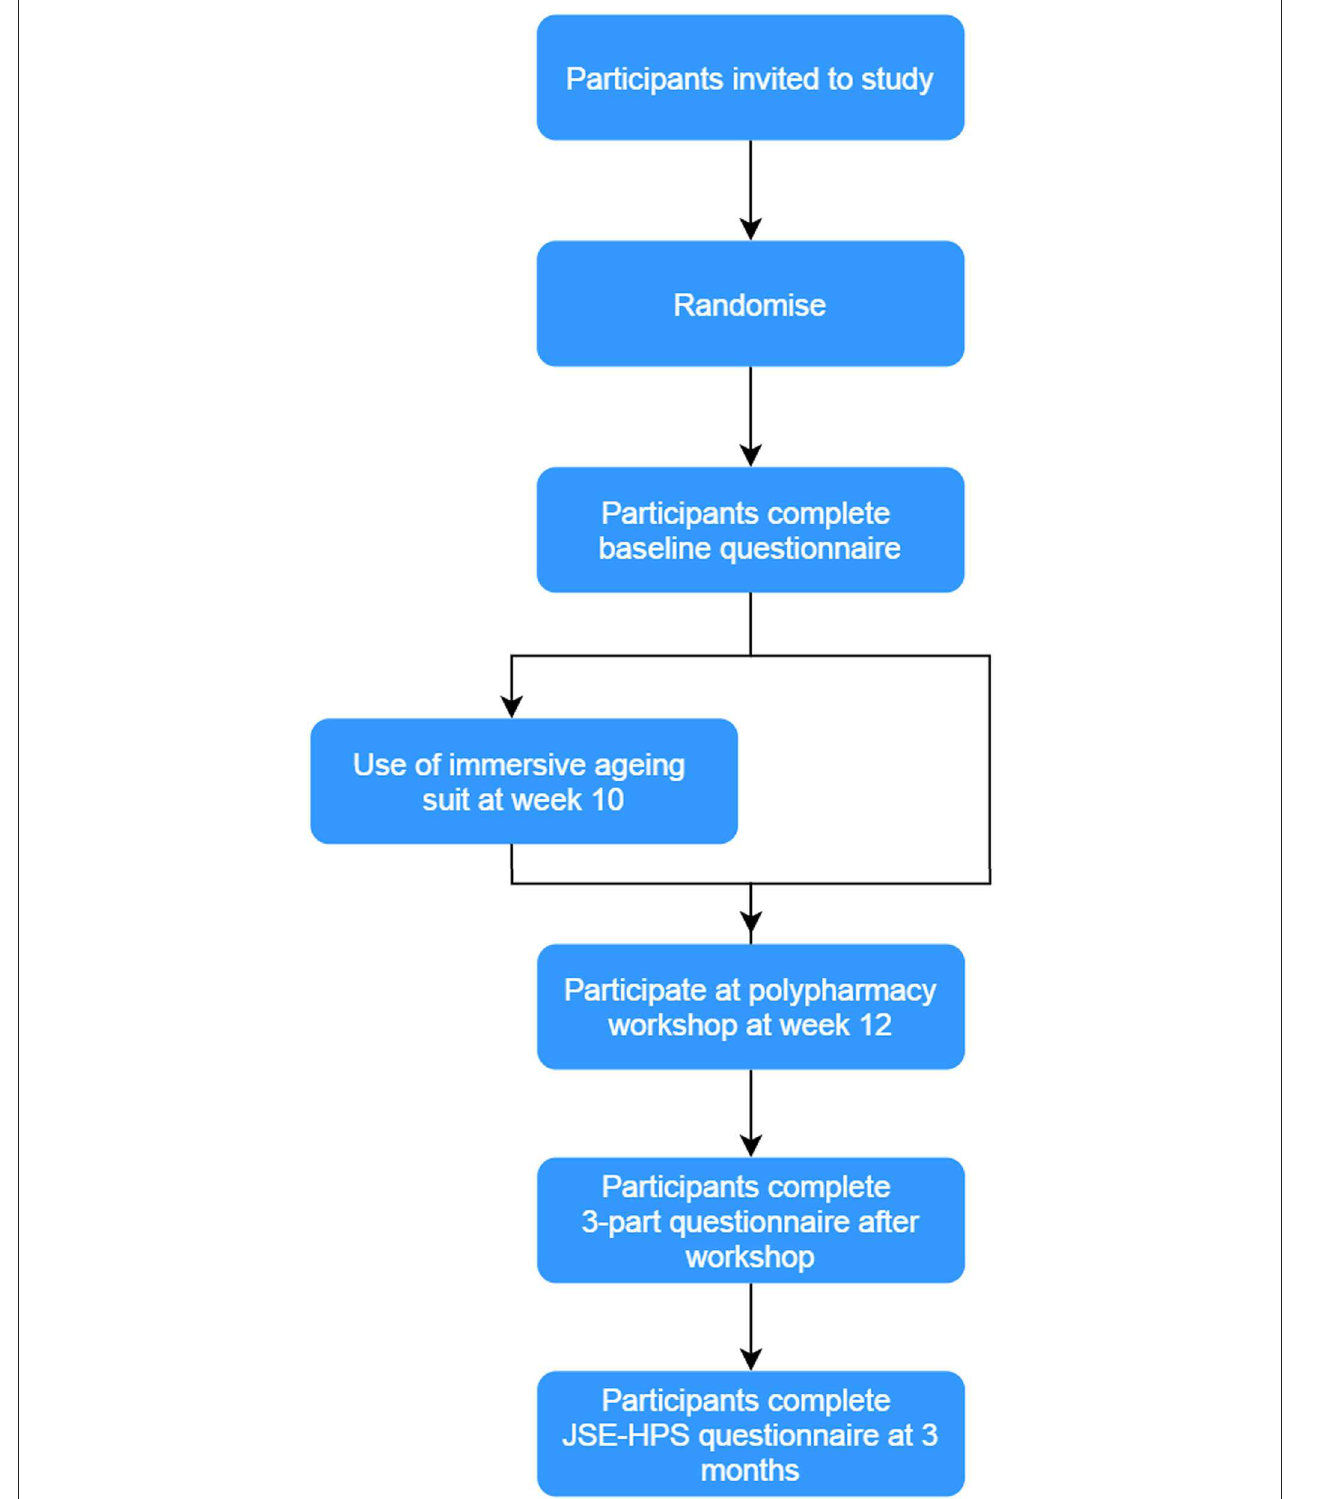
FIGURE 2 | Overview of study. Participants who agreed to the study were randomized 1:1 to either an immersive aging simulation suit and medication review polypharmacy workshop or medication review polypharmacy workshop (control). All participants completed a baseline questionnaire at week 0 and post-workshop questionnaire at weeks 12 and